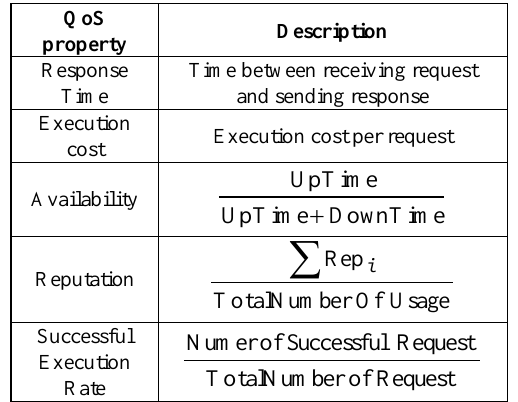
Table 1. Description of QoS peoperties used in this